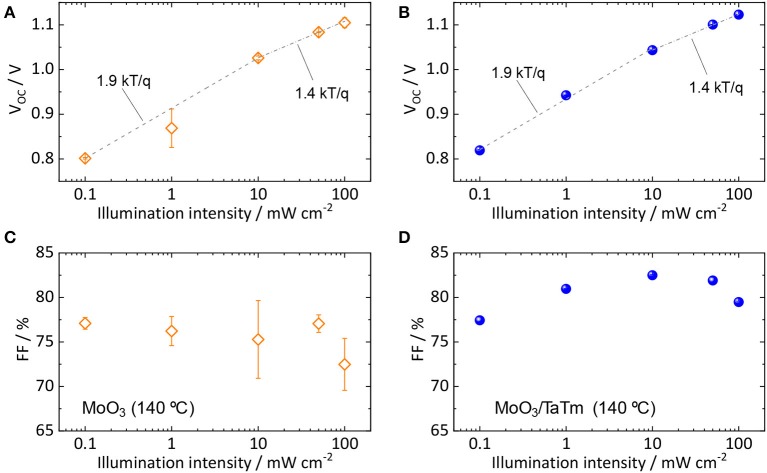
Light intensity dependent characterization of the perovskite solar cells with p-contacts annealed at 140°C. The intensity dependent open-circuit voltage for cells with annealing on (A) the bare MoO3 and on (B) the MoO3/TaTm bilayer has been fitted to extract the ideality factor, reported in the graphs. The dependence of the FF for cells employing annealed (C) MoO3 or (D) MoO3/TaTm bilayers is also reported.